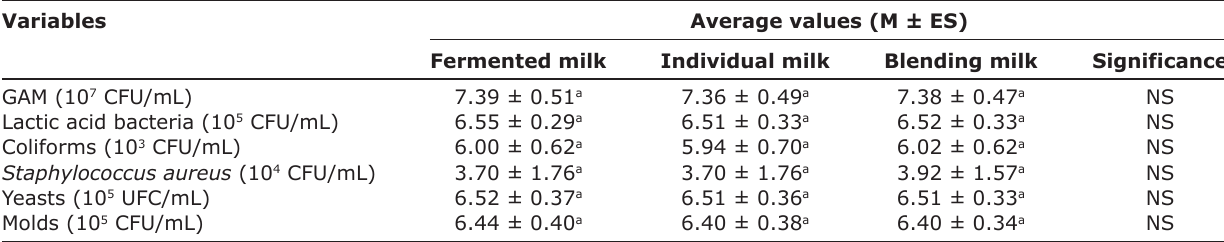
Table-5: Average values of the microorganisms counted according to the various types of milk. Variables